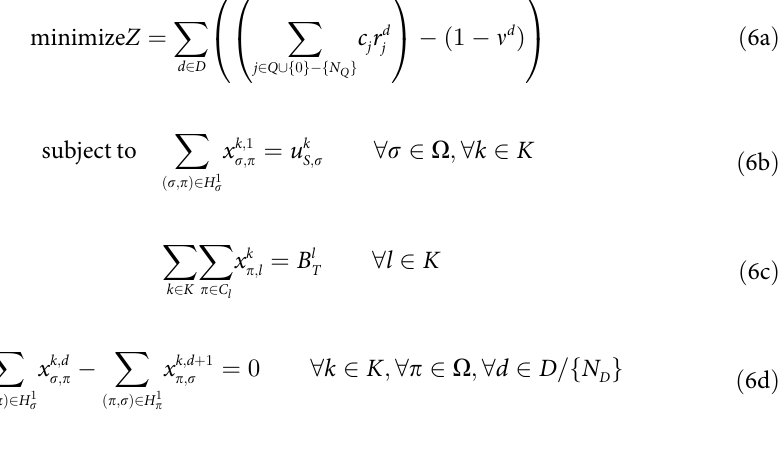
Table 4. Truth table and parameters of completely specified function F 1